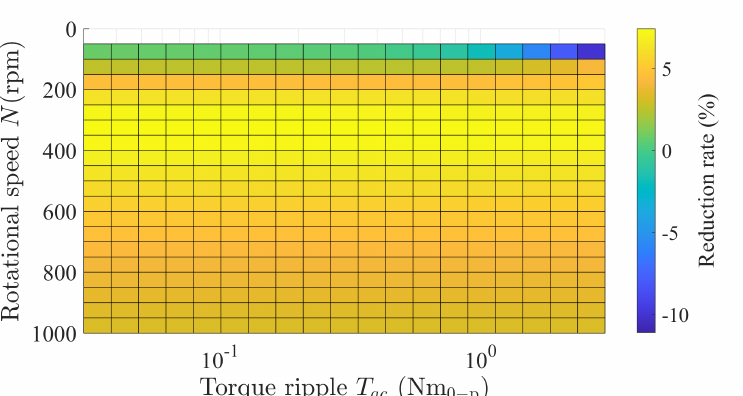
Figure 7. Simulated results of the torque ripple’s reduction rate as a function of rotational speed and torque ripple